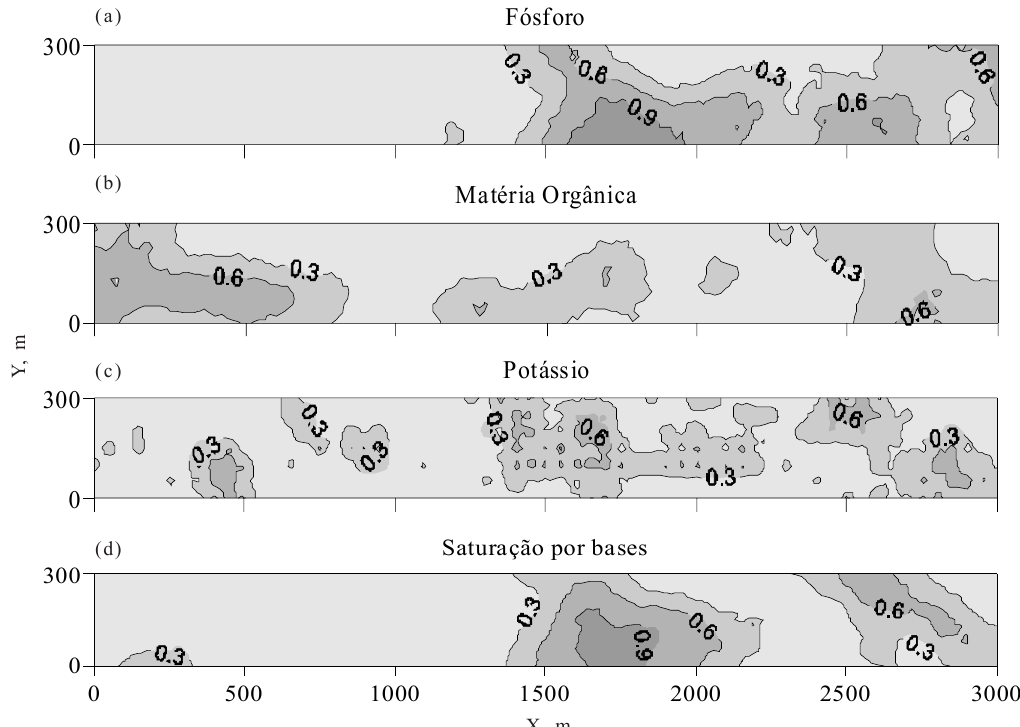
Figura 5. Mapas de probabilidade de as variáveis serem inferiores ou iguais aos valores de corte, correspondentes ao seu respectivo 1 o quartil: (a) P[Z(u) ≤≤≤≤≤ 18,0]; (b) P[Z(u) ≤≤≤≤≤ 26,0]; (c) P[Z(u) ≤≤≤≤≤ 2,3]; e (d) P[Z(u) ≤≤ ≤≤ ≤